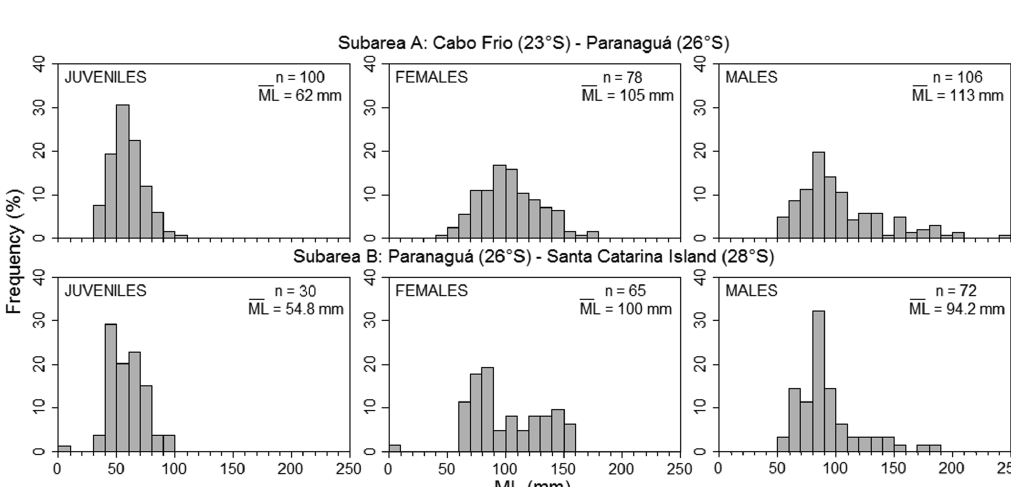
Figure 9. Size structure of Doryteuthis pleii caught off southern Brazil. ZOOLOGIA 35: e23176 | DOI: 10.3897/zoologia.35.e23176 | October 4,